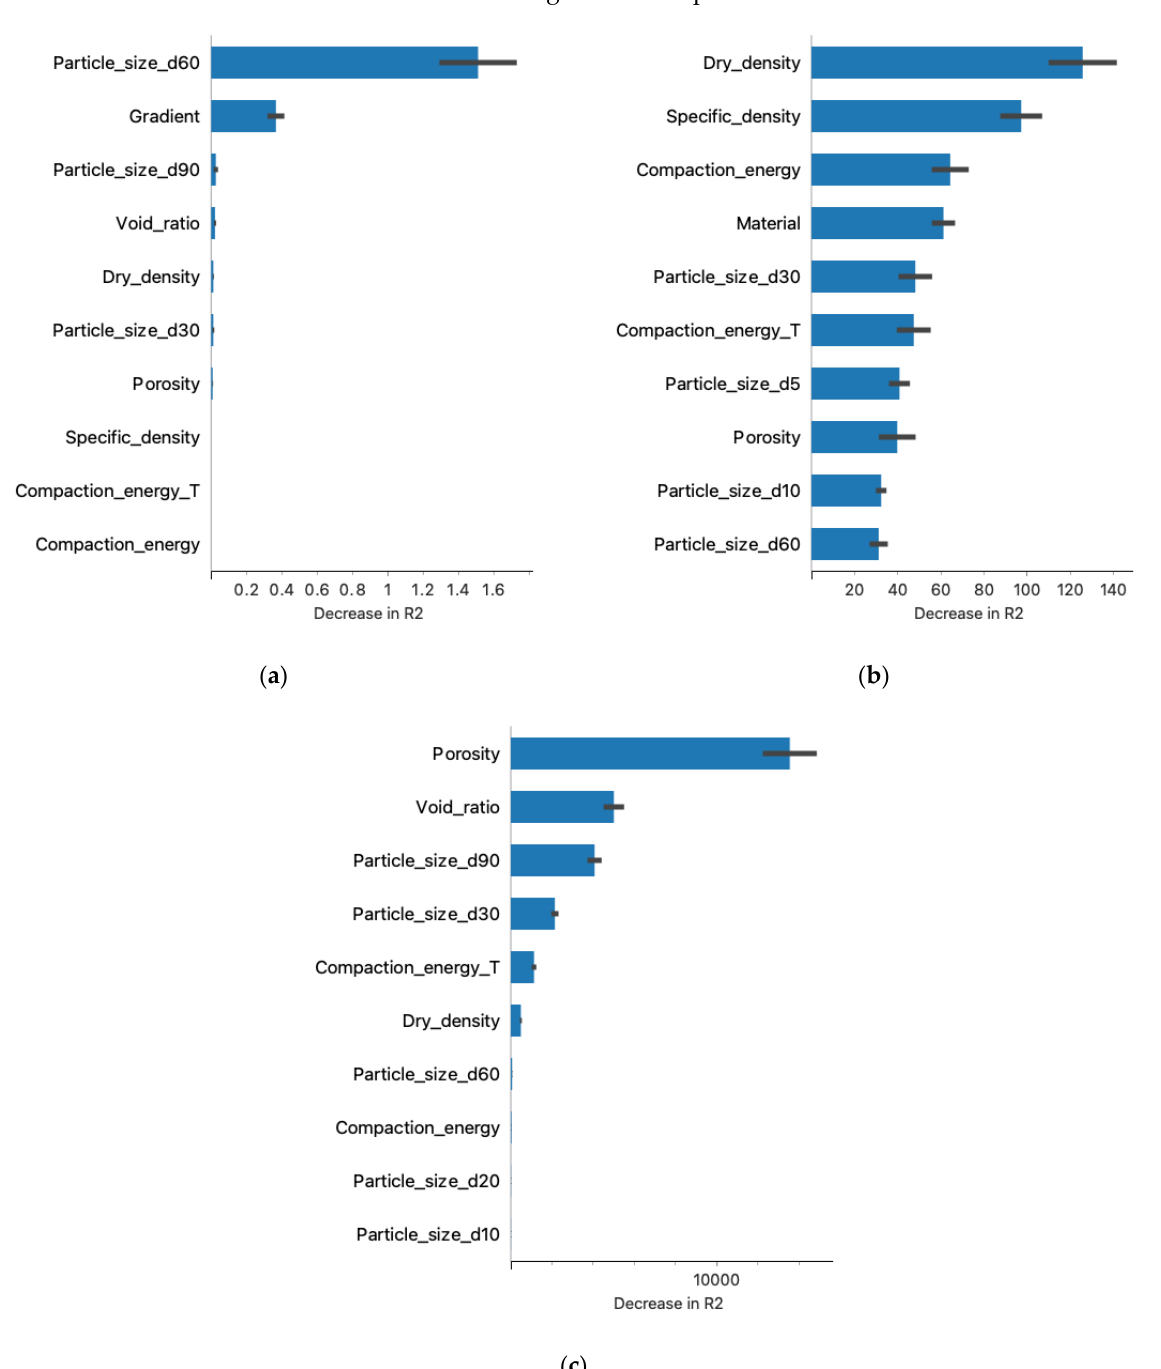
Figure 8. The results of the significance of the various features of the models: ( a ) k-NN. ( b ) Neural network. ( c ) Linear regression.